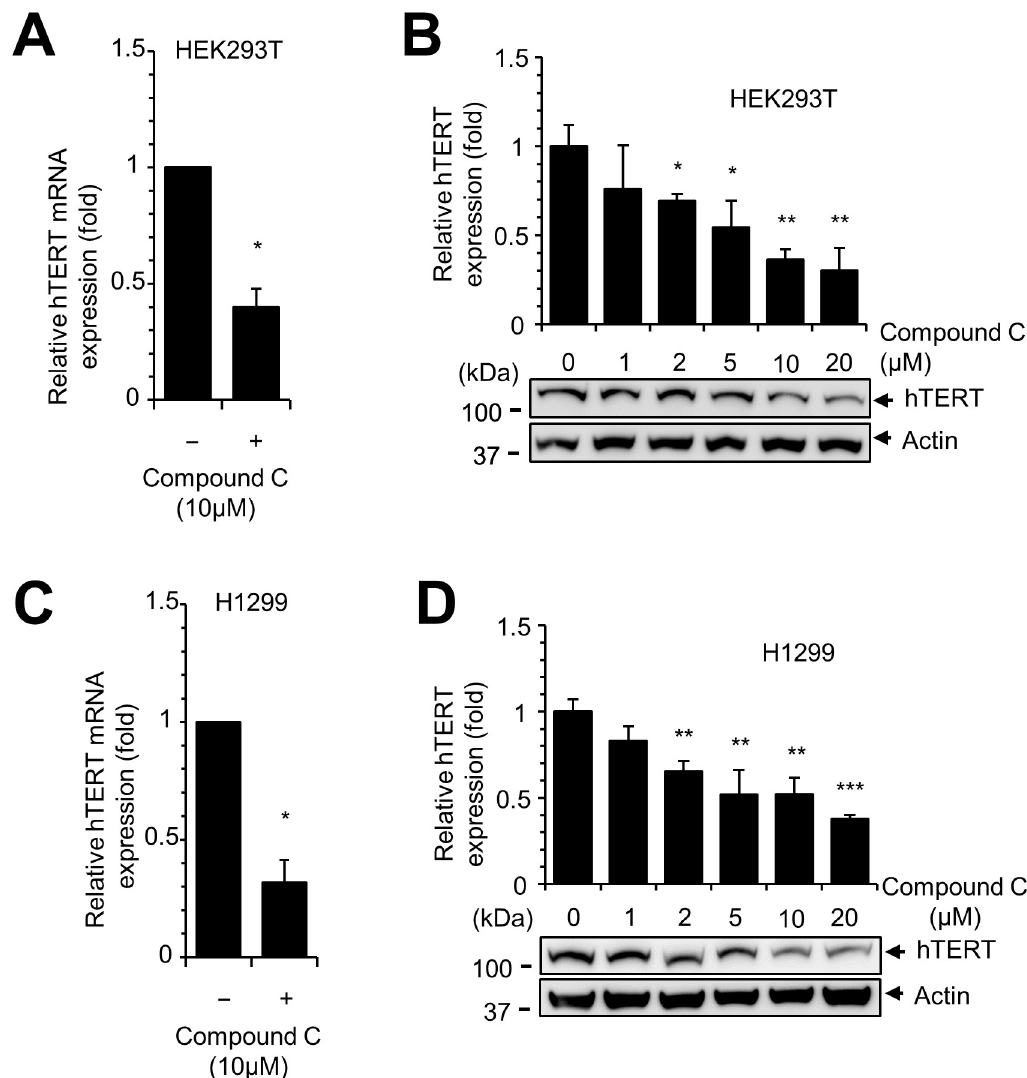
real-time PCR and western blotting. Control vs. drug treated, � P < 0.05, �� P < 0.005, ��� P < 0.001. ( C, D ) H1299 cells were treated with the indicated concentrations of compound C for 12 h, and the expression of hTERT was measured by quantitative